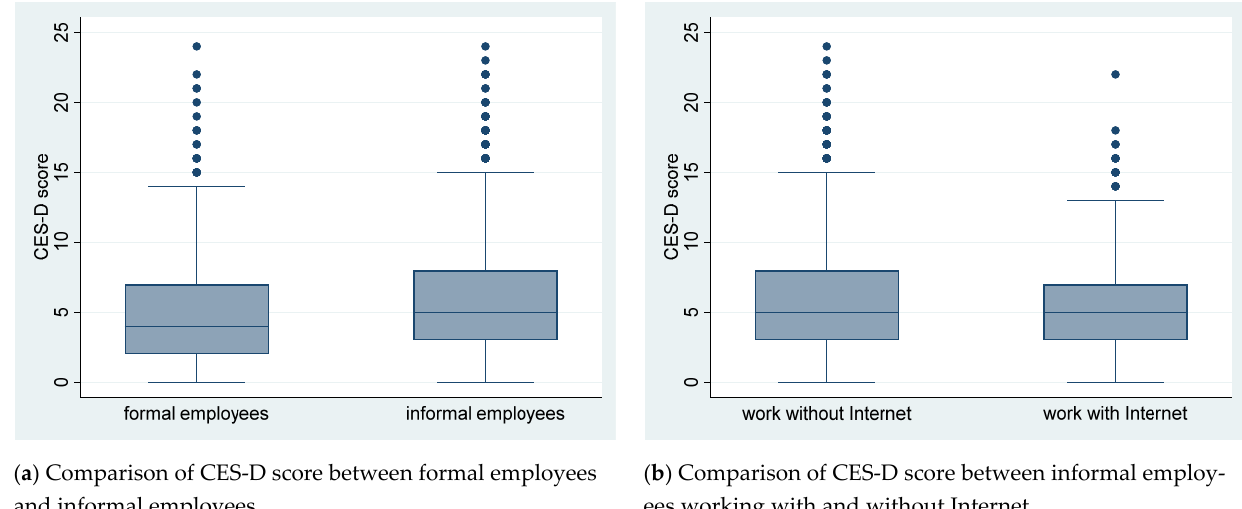
Figure 1. Histogram of CES-D score distribution.